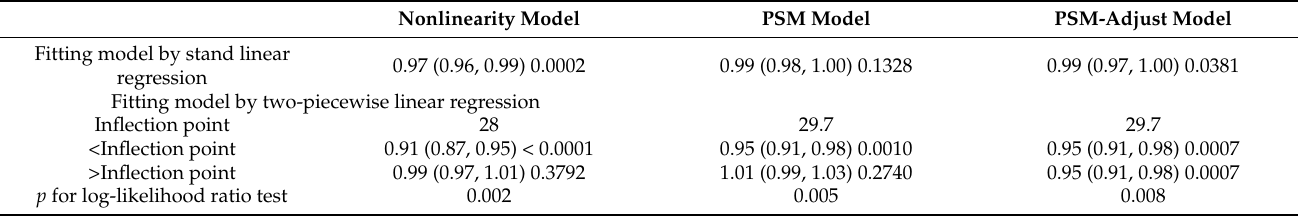
Table 4. Multivariate results by cox regression in PSM model (N = 1400).